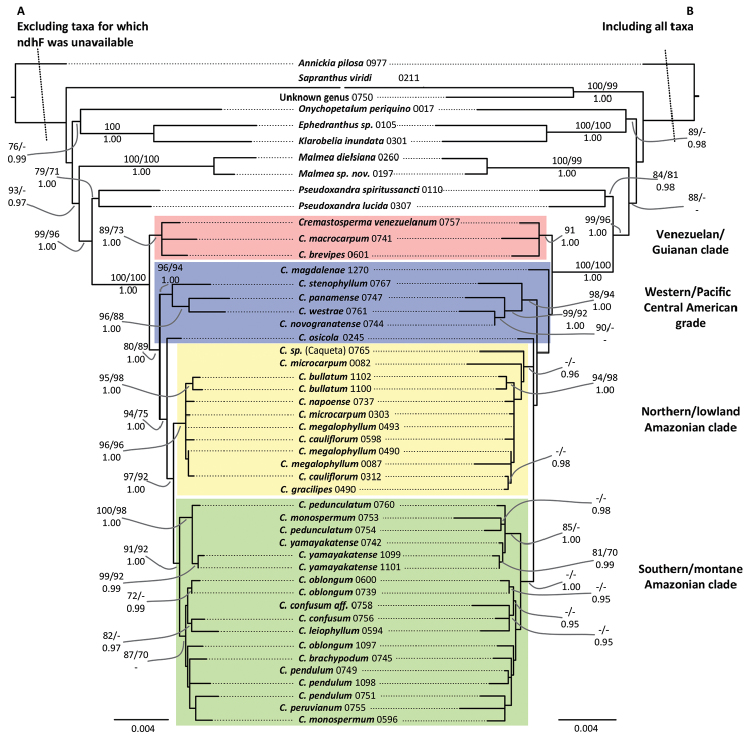
Phylogenetic hypotheses for Cremastosperma based on rbcL, matK, trnT-F, psbA-trnH, ndhF and pseudtrnL-F (adapted from Pirie et al. (2018)). A Excluding taxa for which ndhF was unavailable B including all taxa. Topologies and branch lengths are of the best scoring ML trees with scale in substitutions per site. Branch lengths subtending the ingroup are not to scale. Clade support is indicated: ML and parsimony bootstrap percentages (above; left and right, respectively) and Bayesian posterior probabilities (below). Geographically restricted clades/lineages are highlighted with different colours and labelled on the right.